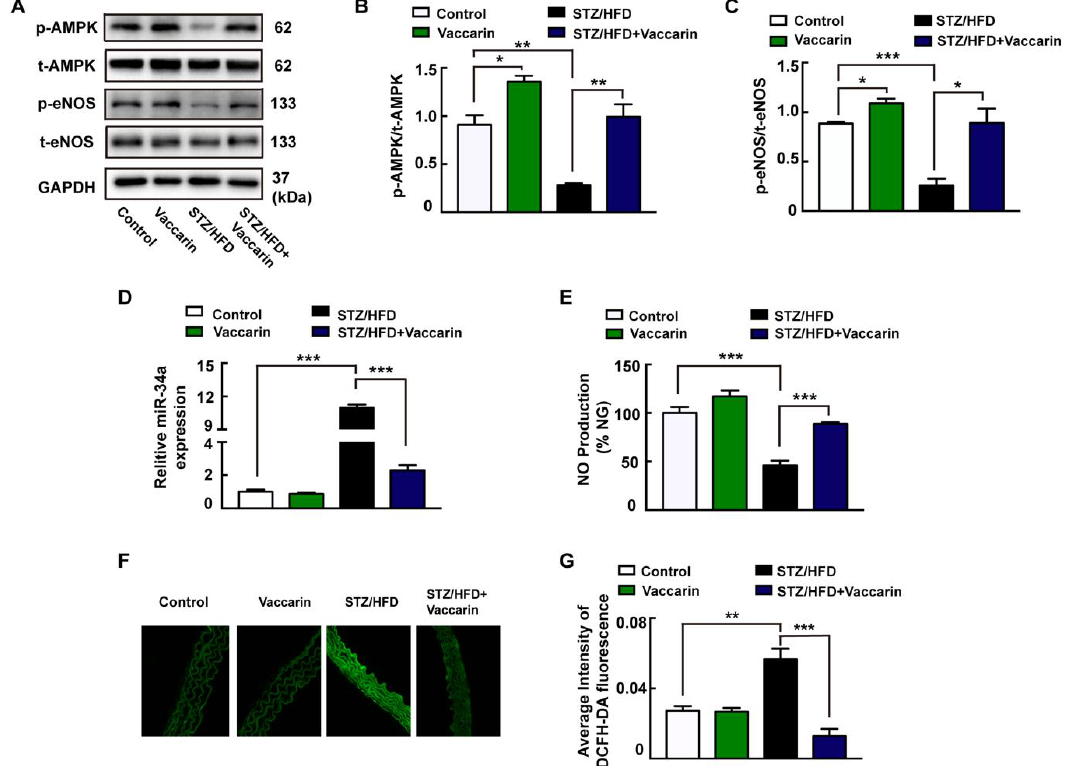
Figure 6. VAC repressed endothelial dysfunction and suppressed ROS / AMPK / miRNA-34a / eNOS signaling cascade in vivo. ( A ) Representative blots showing aortic protein expressions of p-AMPK and p-eNOS. Column groups showing that the quantification of p-AMPK / t-AMPK ( B ) and p-eNOS / t-eNOS ( C ). ( D ) The expression of miR-34a. ( E ) Serum NO generation detected with ELISA. ( F ) Representative microscopic scans of ROS (